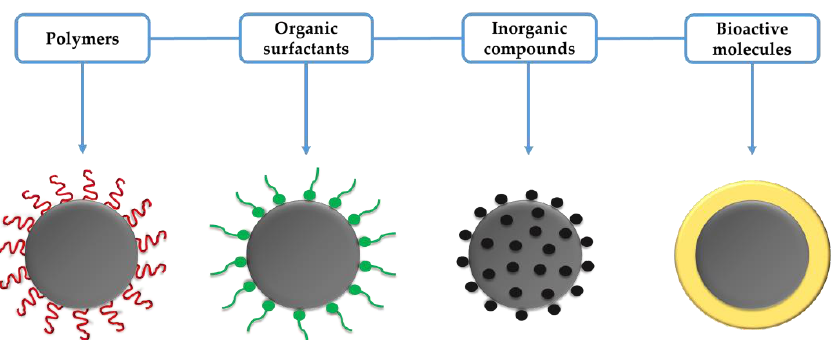
Figure 1. Schematic illustration of the main shells for functionalization of iron oxide nanoparticles (IONPs). Grey circles represent the core of IONPs.